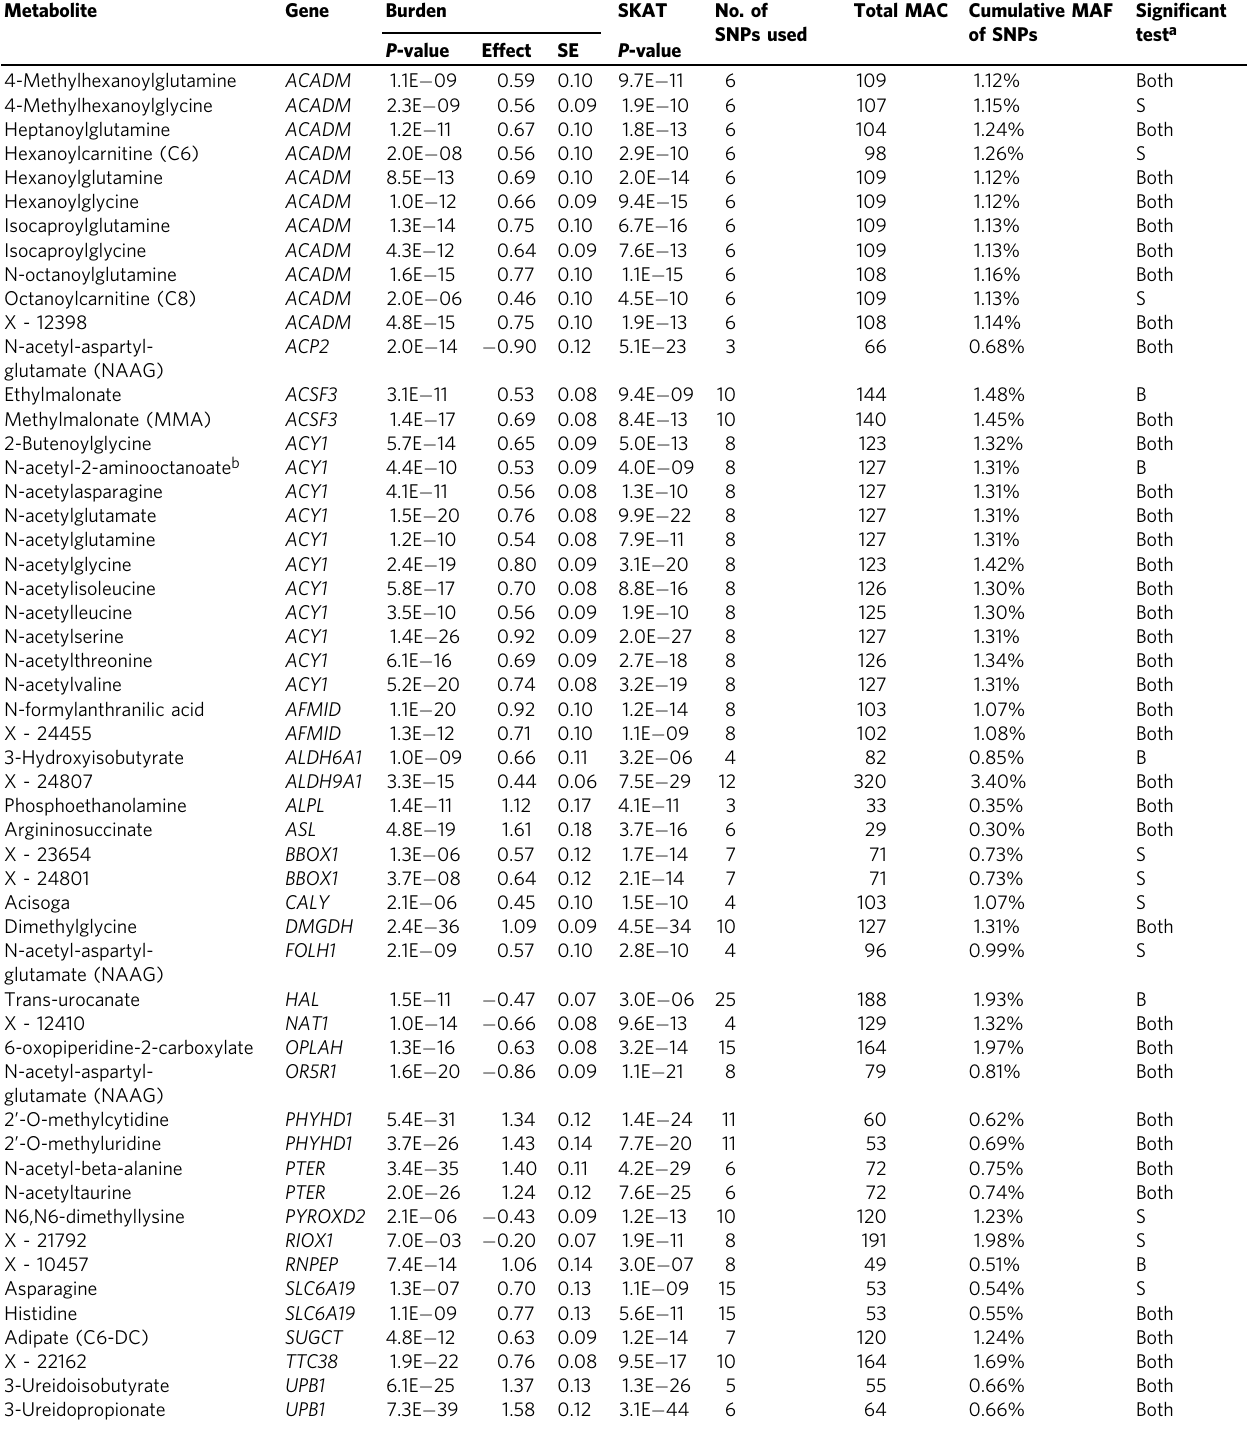
Table 1 Genes signi fi cantly associated with urine metabolite levels ( p < 1.46E − 9).